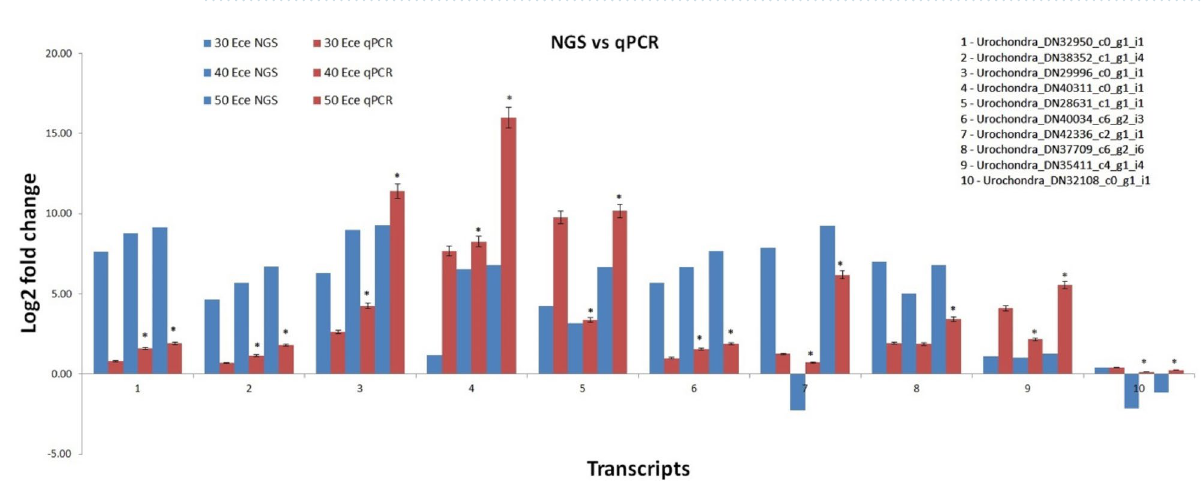
Figure 8. Comparative gene expression between qPCR analysis and RNA-Seq data (mean ± SE); * significantly different from the control ( P <